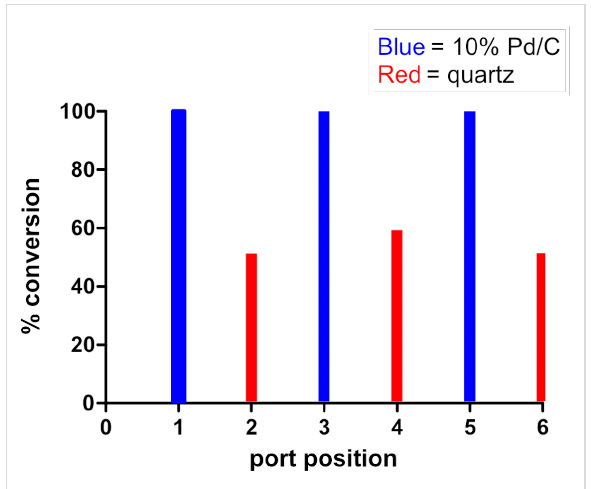
Figure 6: Conversion of styrene to ethylbenzene in a sequence of reactions alternating between 10% Pd/C and quartz-loaded CatCart ® cartridges on the AutoH 3 system. All reactions were carried out at a flow rate of 1.0 mL/min, at 30 °C, with 0.5 M styrene in MeOH, with 1 mL injection per reaction, and run in order from 1 through to 6. The conversion was determined by GC–MS analysis with decane as an internal standard. Data represented in blue correspond to reactions performed through a 30 mm 10% Pd/C CatCart ® . Data represented in red correspond to reactions performed through 30 mm quartz CatCart ® .